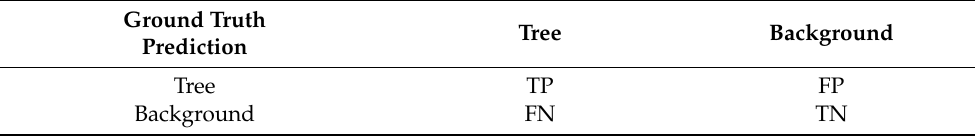
Table 2. Confusion matrix for accuracy evaluation. Ground Truth Tree Background Prediction Tree TP FP Background